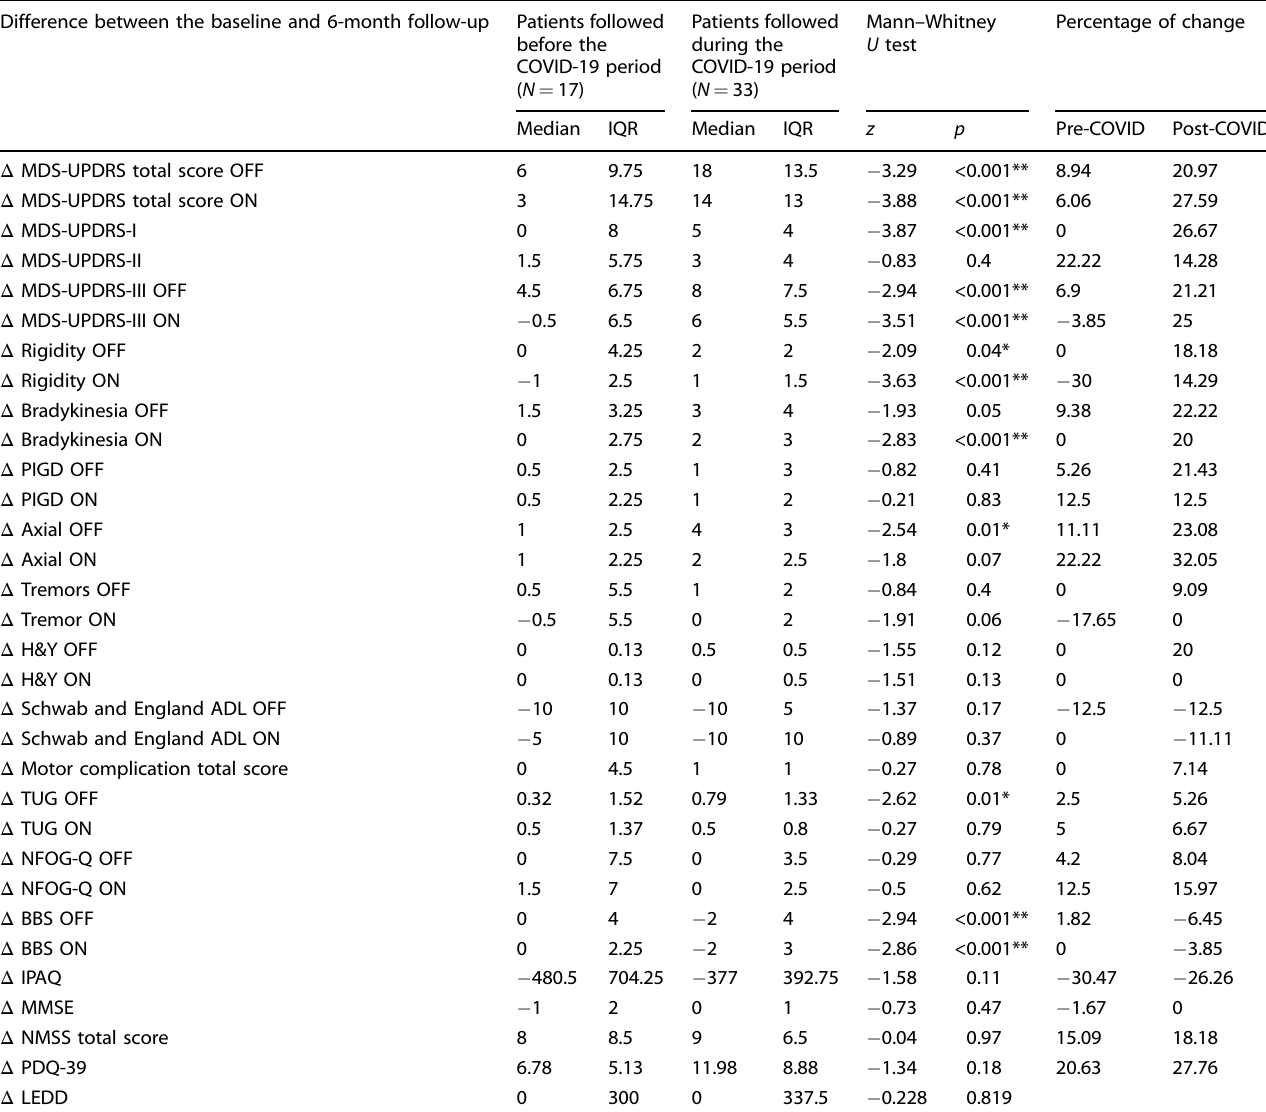
Table 2. Comparison of 6-month disease progression before and during the COVID-19 pandemic. Difference between the baseline and 6-month follow-up Patients followed before